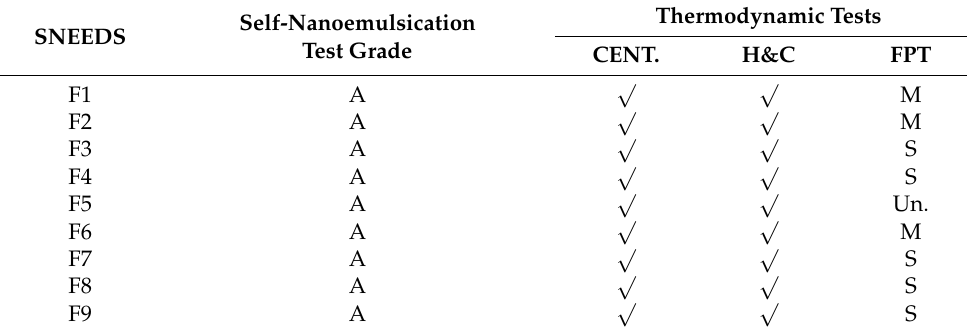
Table 3. Results for self-nanoemulsication and thermodynamic